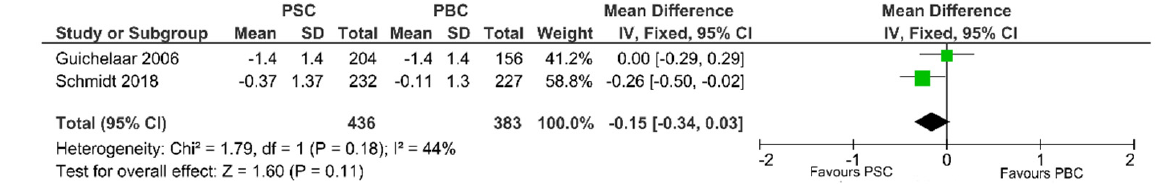
Figure 5. Forest plot assuming a fixed-effects model for Z-score PSC vs. PBC [30,33].